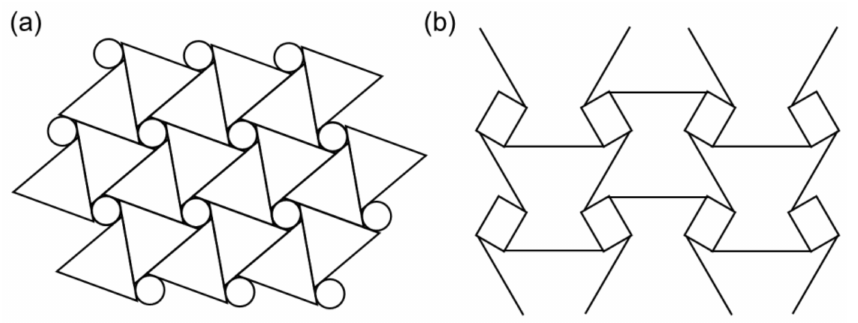
Figure 3. Chiral structures. ( a ) chiral structure with same units, ( b ) chiral structure with symmetrical units [9].